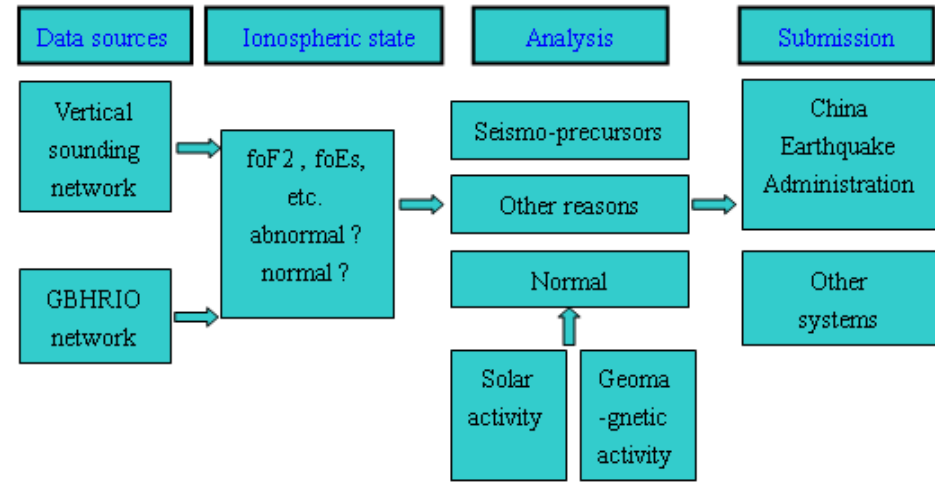
Fig. 7. Two-dimensional map of NmF2 (1 . 24 × 10 4 ( fo F2) 2 ) based on the GBHIO network.